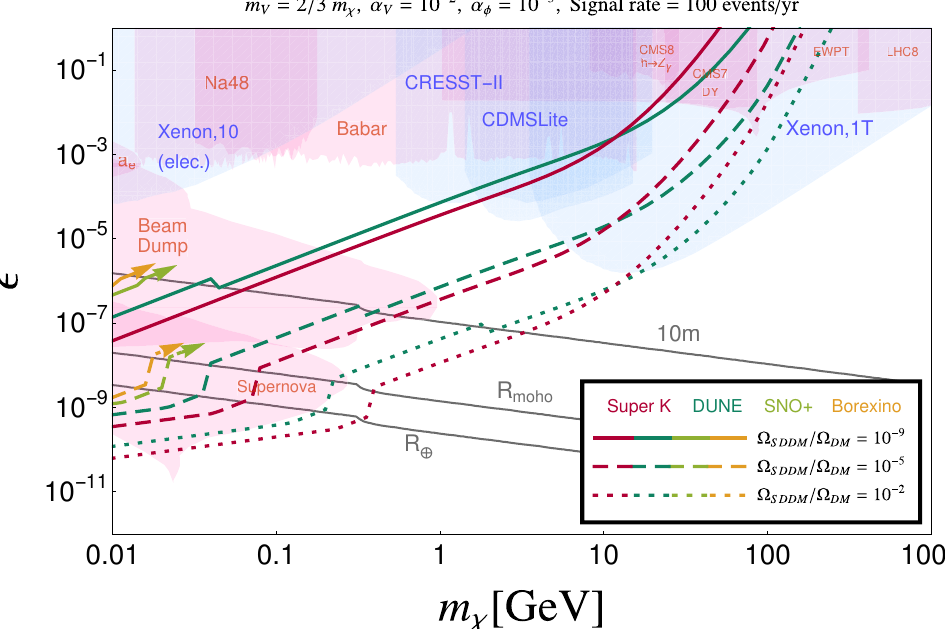
Figure 2 . Contours that give 100 DM self-destruction events per year in the (cid:31) space of the angular momentum model. The other parameters are chosen to be m α V = 0 . 01, α φ = 0 . 001. The colorful thick curves correspond to Super-Kamiokande (red), and DUNE (dark green). Contours for SNO+ (light green), Borexino (orange) are shown as arrows in order to reduce the number of curves with the understanding that they run parallel to that of Super- K. The solid, dashed and dotted curves assume the initial DM bound state is Ψ 9 , 10 5 and 10 2 of the total DM relic density, respectively. The gray curves correspond to 10 − − − constant decay length contours of the dark photon V (see section 6 for their effect on the signal characteristics). The light red and blue shaded regions show the existing experimental constraints from searching for visibly-decaying dark photons and DM direct detection (assuming χ to be the dominant DM),